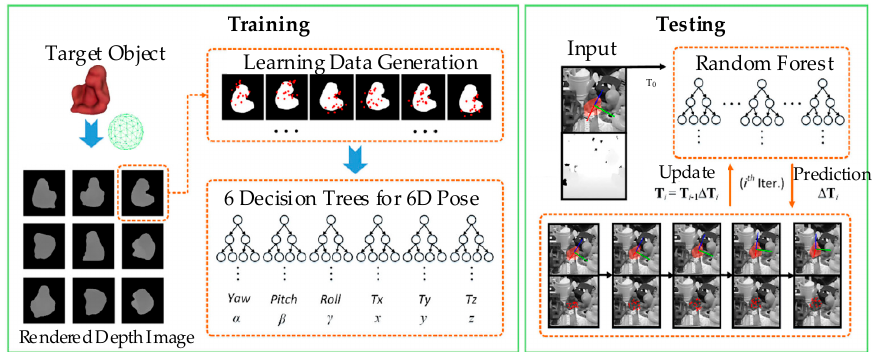
Figure 5. The whole pipeline of the random forest approach [46].